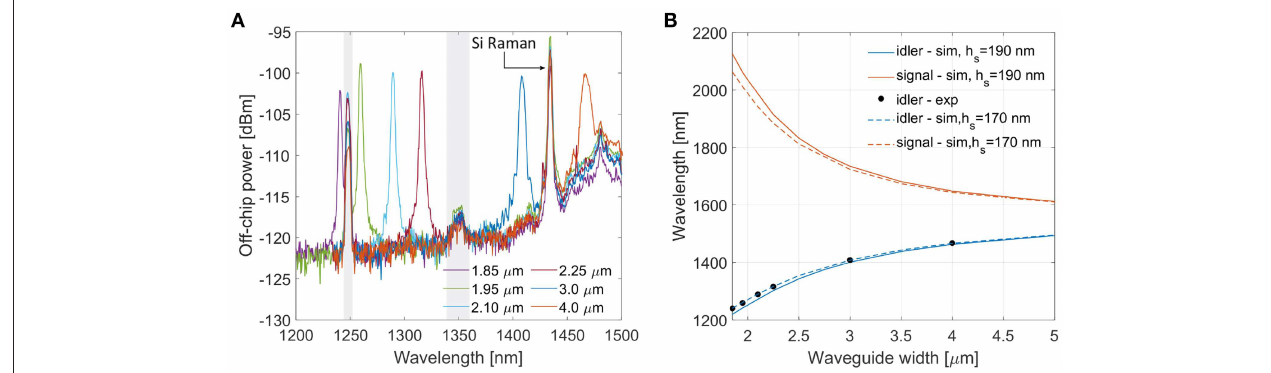
FIGURE 6 | (A) Spectra of the generated idler for the 1221TE inter-modal combination in a spontaneous FWM experiment. Different waveguide widths are considered (width values in the legend). The peak at 1,434nm is the anti-Stokes Raman from silicon. The broad peak at 1,475nm is the anti-Stokes Raman peak due to the silica input fiber. The gray boxes highlight peaks due to ghosts in the grating monochnromator. (B) Simulated and measured idler and signal phase matched wavelengths as a function of the waveguide width. The experimental idler wavelengths are shown by black dots, errors are within the dot sizes. Two simulation results are shown with h s = 190nm (full blue line) and with h s = 170nm (dashed blue line).